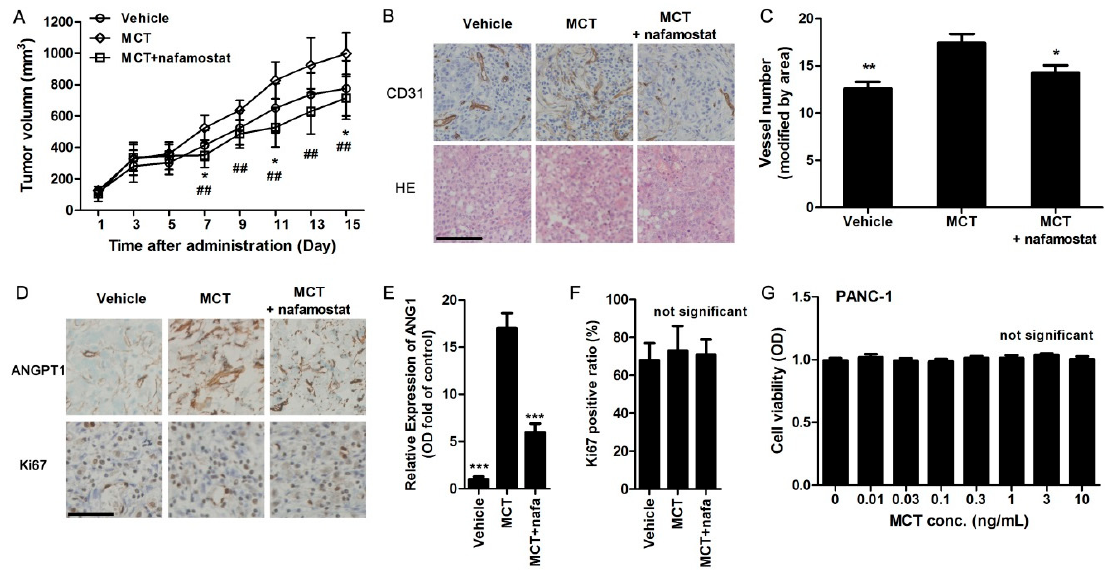
Figure 4. MCT promotes pancreatic cancer cells tumorigenesis via increasing angiogenesis in vivo . ( A ) Nude mice bearing pancreatic tumor were subcutaneously injected with MCT (200 ng/kg) or MCT along with nafamostat (10 mg/kg) daily, while vehicle mice received saline. The tumor volume was measured every two days after tumor formed with injection of PANC-1 cells. * p < 0.05 indicated MCT-treated group and vehicle group, ## p < 0.01 indicated MCT-treated group and nafamostat co-treated group, n = 10; ( B ) After experiments, tumor tissues were removed and embedded for paraffin sections. IHC staining for CD31 and Hematoxylin-Eosin (HE) staining were performed, scale bar = 100 μ m and refer to all panels; ( C ) The microvascular density in tumor tissues was calculated as CD31-positive vessel number (random 10 images, adjusted by tumor areas), * p < 0.05, ** p < 0.01 compared to MCT-treated group; ( D ) IHC staining for ANGPT1 and Ki67, nuclei were stained with hematoxylin, scale bar = 100 μ m and refer to all panels; ( E ) Optical density (OD) was measured from 10 random images of ANGPT1 staining in each animal, *** p < 0.001 compared to MCT-treated group, n = 10; ( F ) Ki67-positive ratio was calculated as Ki67-positive nuclei number divided by total hematoxylin-stained nuclei, n = 10; ( G ) After PANC-1 cells were treated with different concentration of MCT for 24 h, CCK8 assays were used to determine the cell viability, n = 6. All statistical difference were analyzed by ANOVA and Student-Newman-Keuls tests.